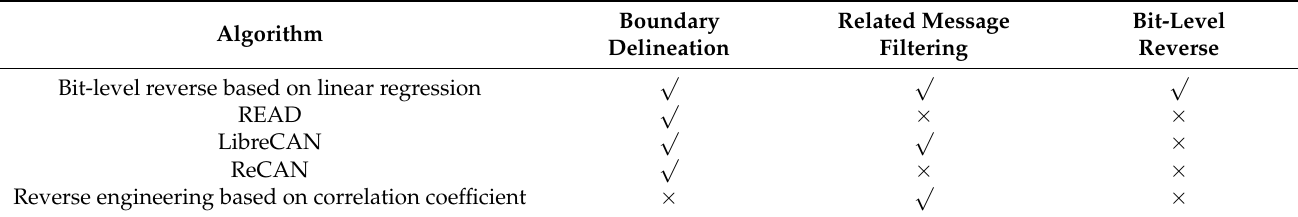
Table 9. Reverse function compared with existing algorithms.